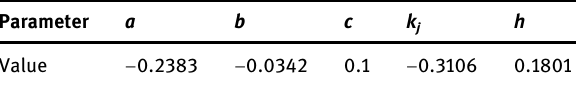
Table 3: Unknown parameters of the geometric structure Parameter